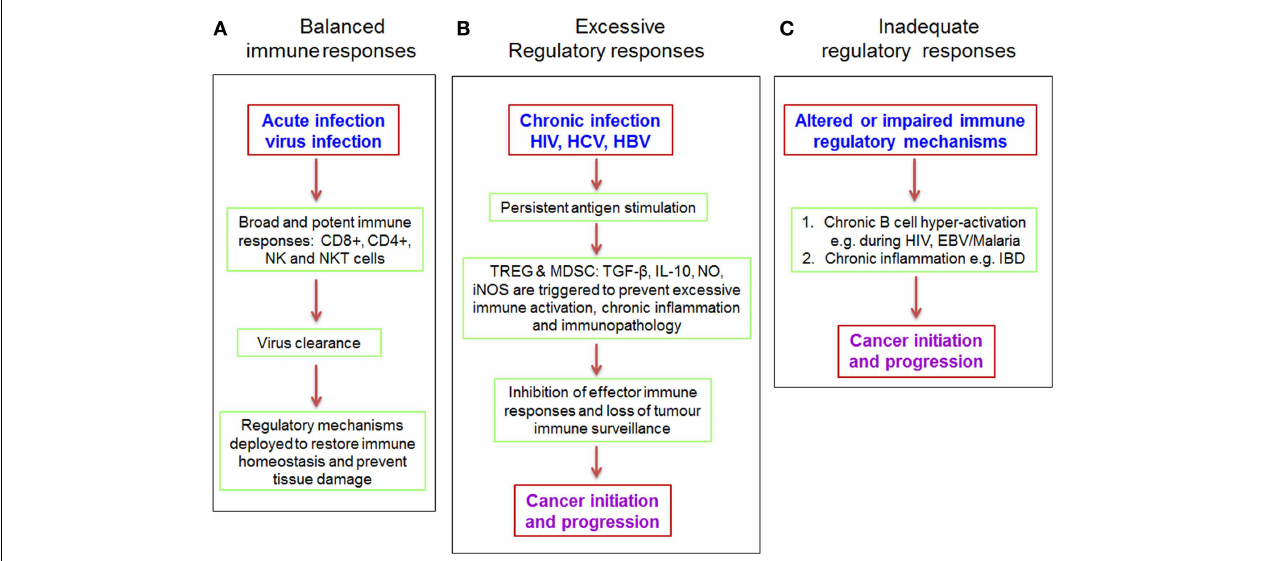
incapable of clearing the pathogen.This leads to a state of chronic inflammation that in turn triggers regulatory pathways such as increased production of suppressive cytokines and recruitment ofTreg and MDSC to dampen excessive immune responses and prevent tissue damage (136).